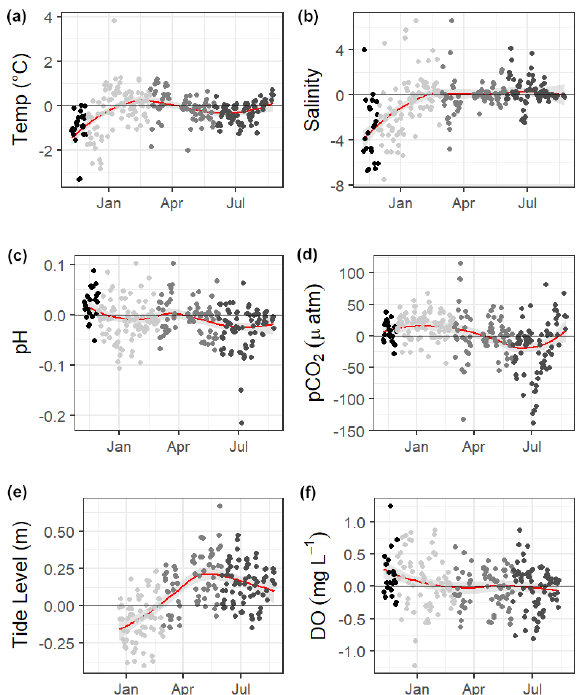
Figure 5. Loess models (red line) and their confidence intervals (gray bands) showing the difference in daily daytime mean minus nighttime mean measurements. The gray scale of the data points represents the four seasons over which data were collected. Data span from 8 November 2016 to 3 August 2017, except for the tide data, which began 20 December 2016.